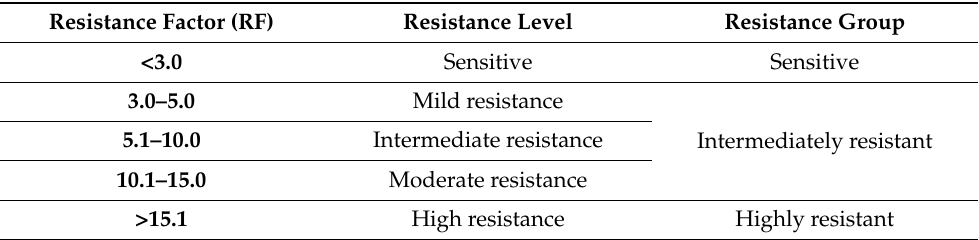
Table 1. Sensitivity grouping based on resistant phenotype (EC 50 )